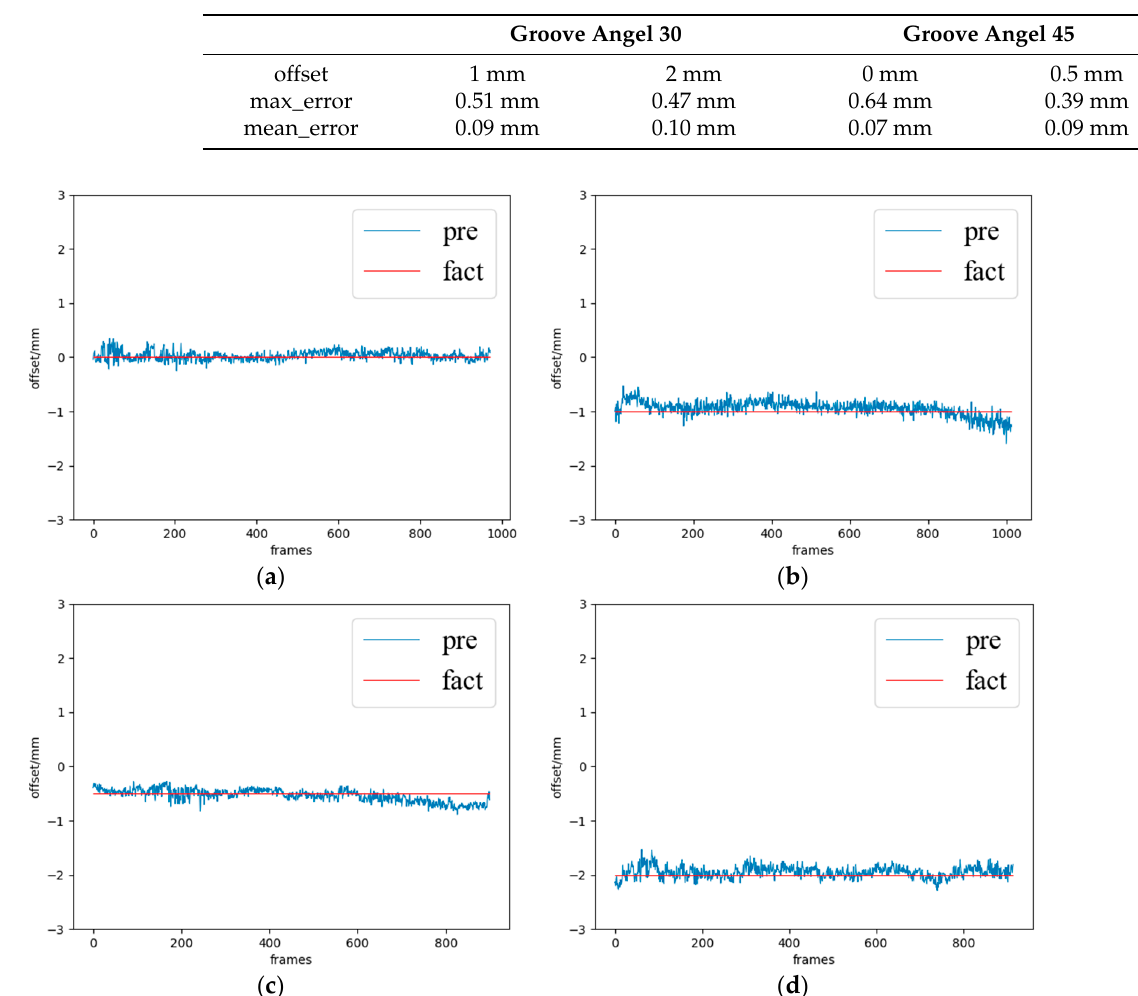
Figure 9. Offset prediction: ( a ) the welding torch moves along the seam; ( b ) the welding torch and welding seam are offset by 1 mm; ( c ) the welding torch and welding seam are offset by 0.5 mm; ( d ) the welding torch and welding seam are offset by 2 mm. Table 3. Errors of prediction.